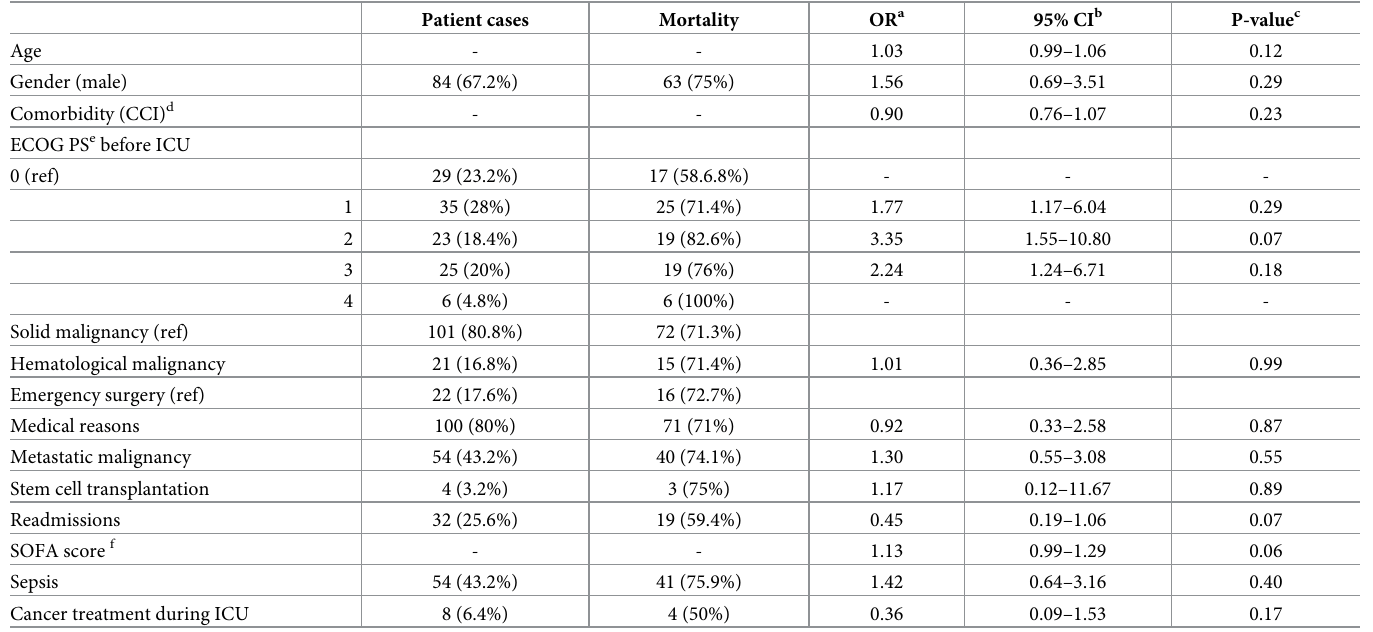
Table 4. Univariable binary logistic regression analysis study population 2-year mortality.